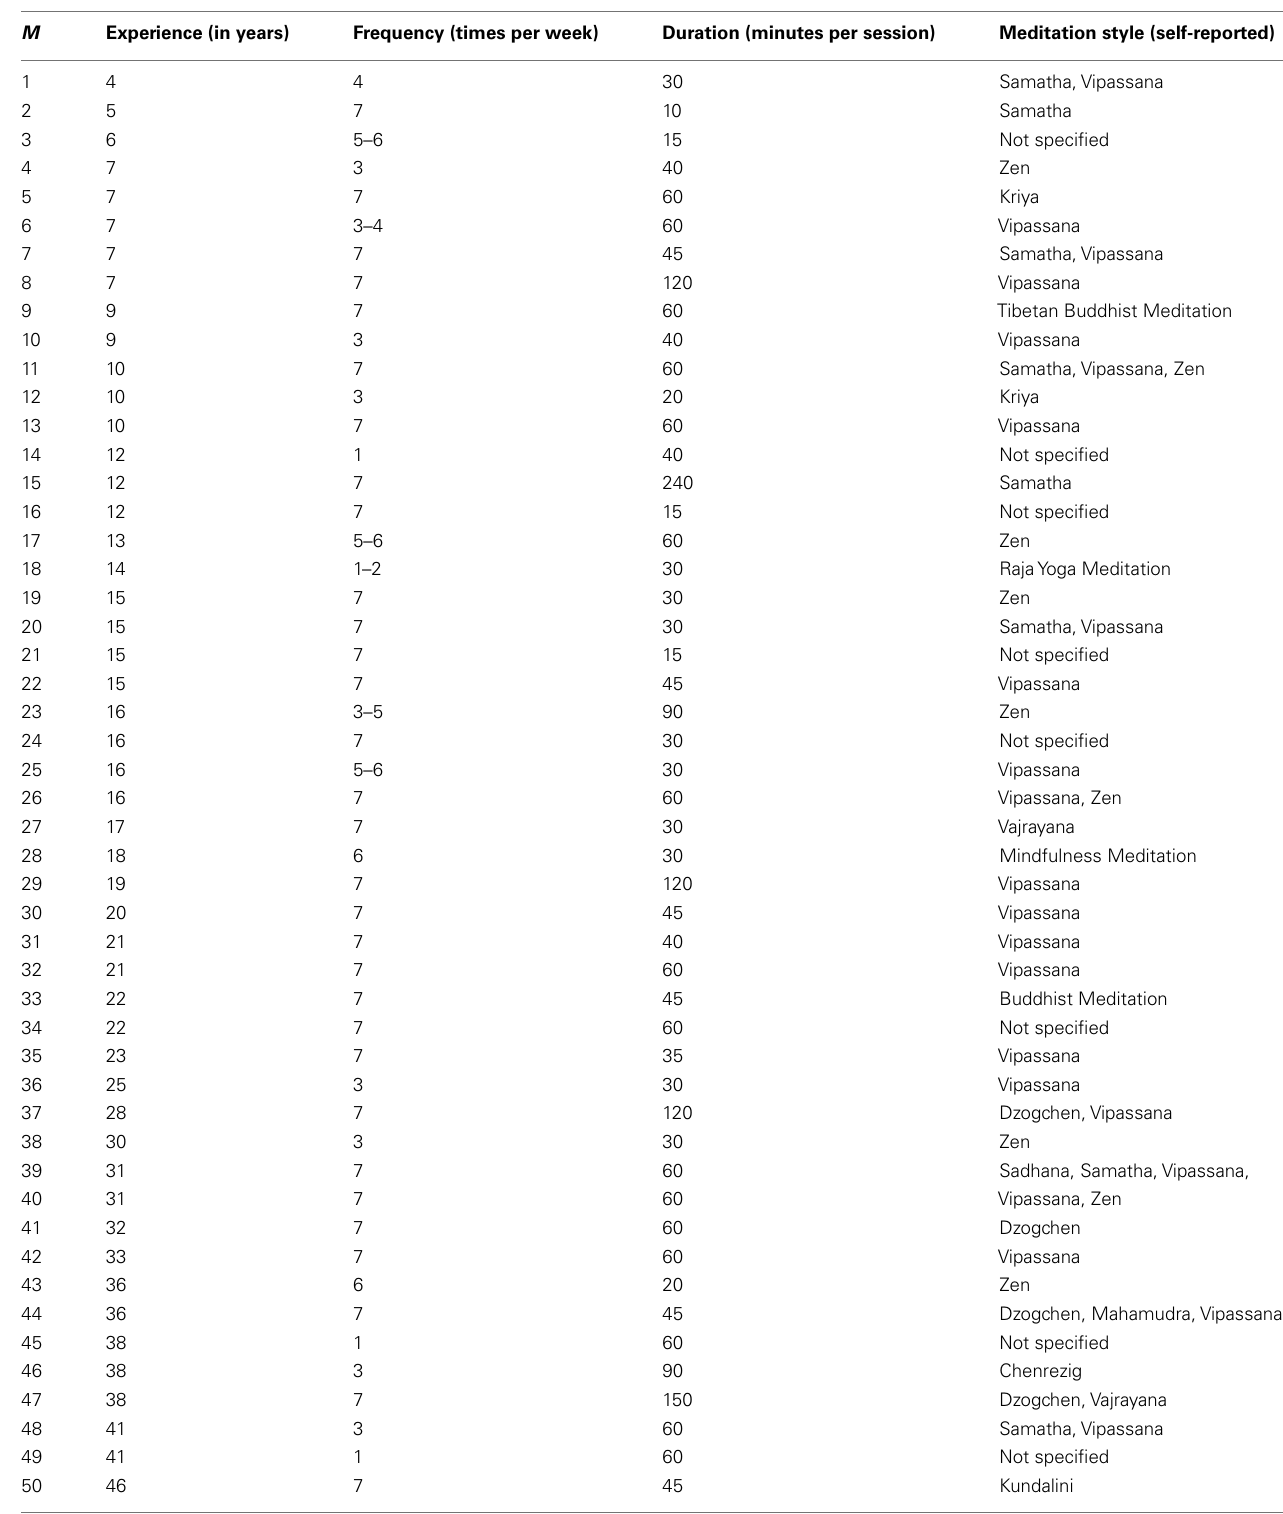
TableA1 | Subject-specific meditation